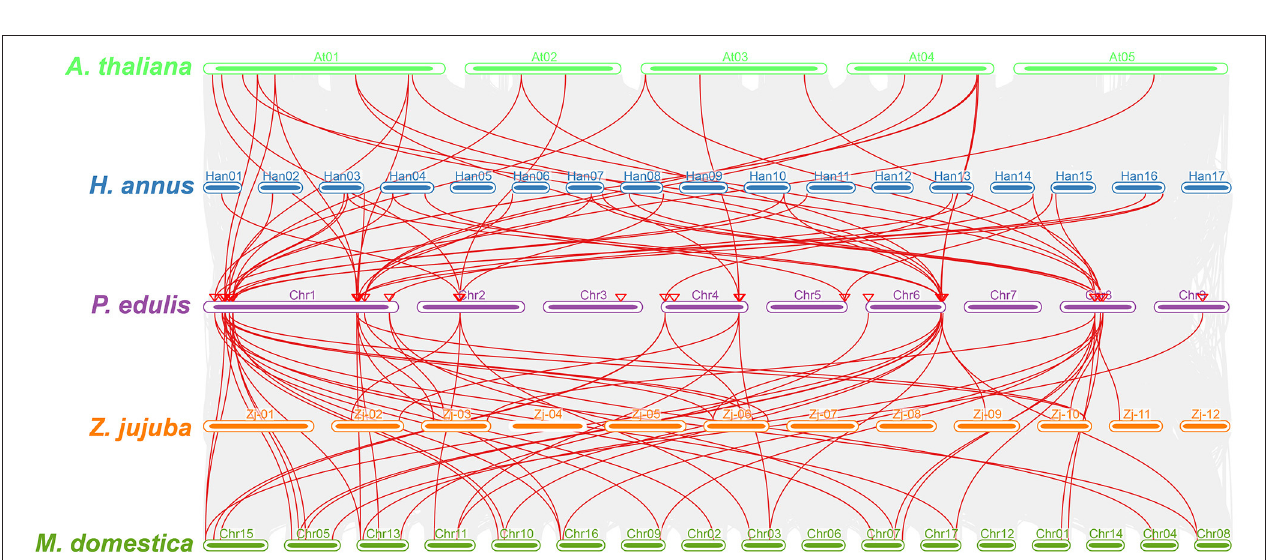
FIGURE 4 | Multicollinearity analysis of the P. edulis CER genes with genomes of the A. thaliana , M. domestica , H. annus , and Z. jujuba species. The red lines represent the CER syntenic genes among P. edulis , A. thaliana , M. domestica , H. annus , and Z. jujube genomes, and the gray lines in the background represent all orthologous genes from the genomes of P. edulis and other